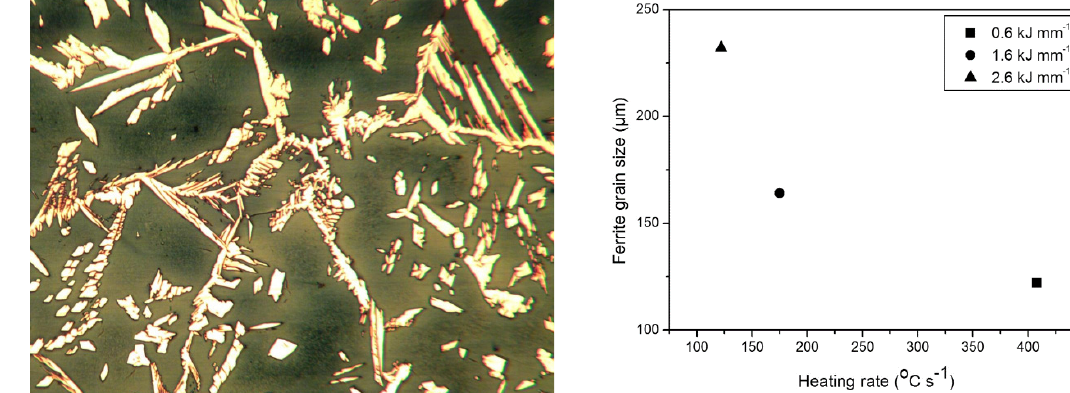
Figure 14. Ferritic grain size versus locally calculated heating rates at the